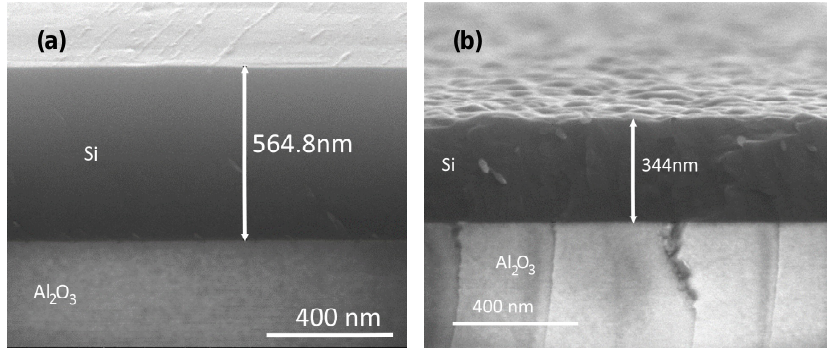
Fig. 2. Typical SEM images of the cross-section and the surface of Si (100) and Si (111) films grown on Al O ; (a) cross-section and surface of the Si (100)/r-plane Al 2 3 the Si (111)/c-plane Al O 2 3